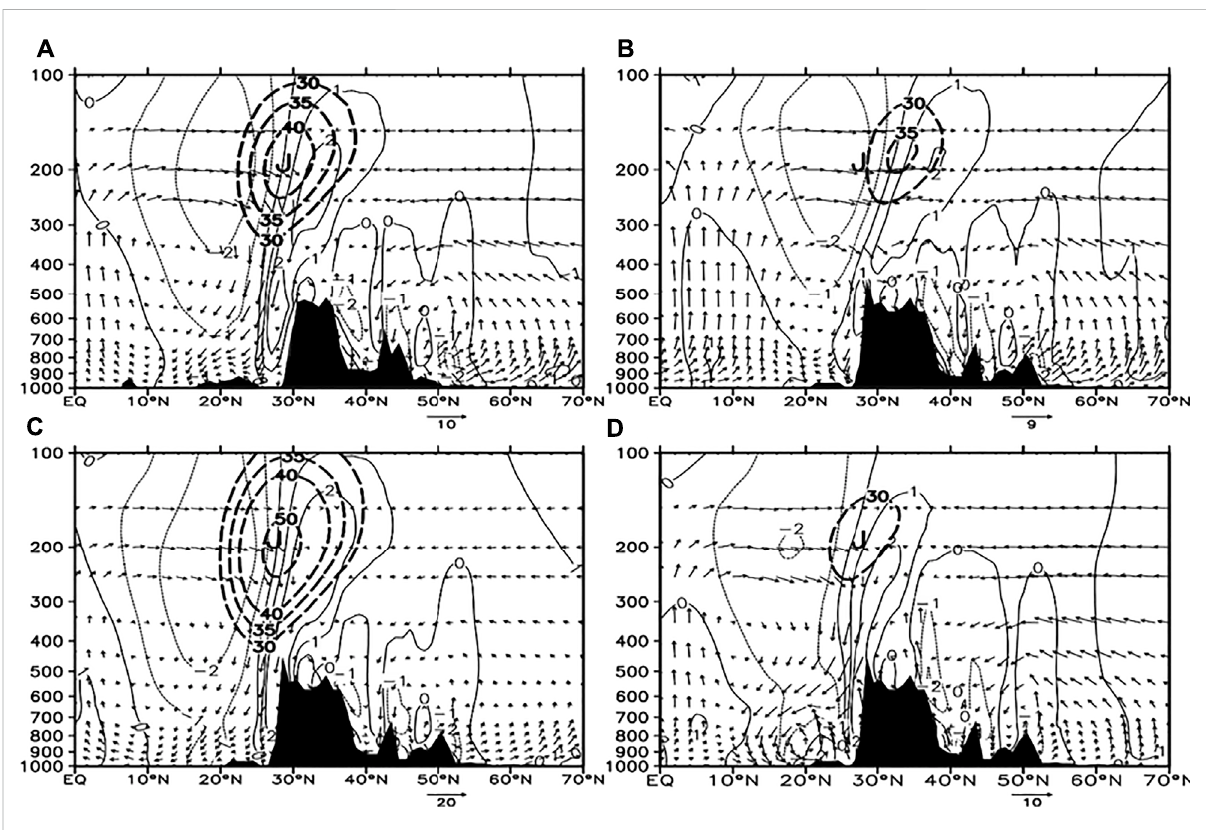
FIGURE 2 Latitude-altitude cross-sections of meridional (unit: m s − 1 ; vector) circulation, vorticity (unit: 10 − 5 s − 1 ; contour) and upper-level jet (u ≥ 30 m s − 1 ; long dashed) averaged in 80 – 90 ° E in (A) winter half-year, (B) autumn, (C) winter, (D) spring. (J) the jet center; shadow: the